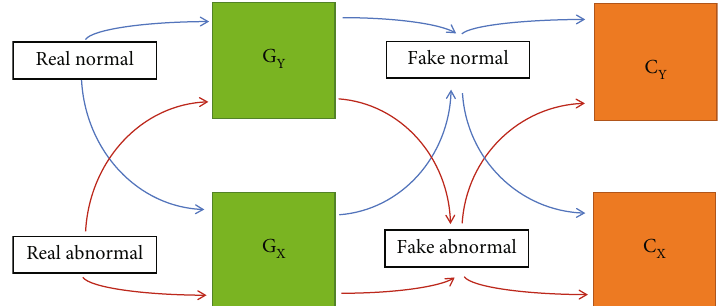
Figure 1: Joint optimization of CycleGAN and CNN classi fi er. A fi xed CycleGAN with a pair of extended classi fi ers was designed to analyze the DR-related pathological characteristics. We de fi ned the X domain as comprised of normal images and the Y domain as containing abnormal images. The generators G X and G Y mapped X and Y functions, respectively. When given a real X domain image as the input, the cycle consistency loss constrains the output of G X to be consistent with the input, while a discriminator and a classi fi er cooperate to optimize the output of G Y to approach domain Y . When the input is a real image of domain Y , the outputs of G X and G Y are opposite to the input of domain X